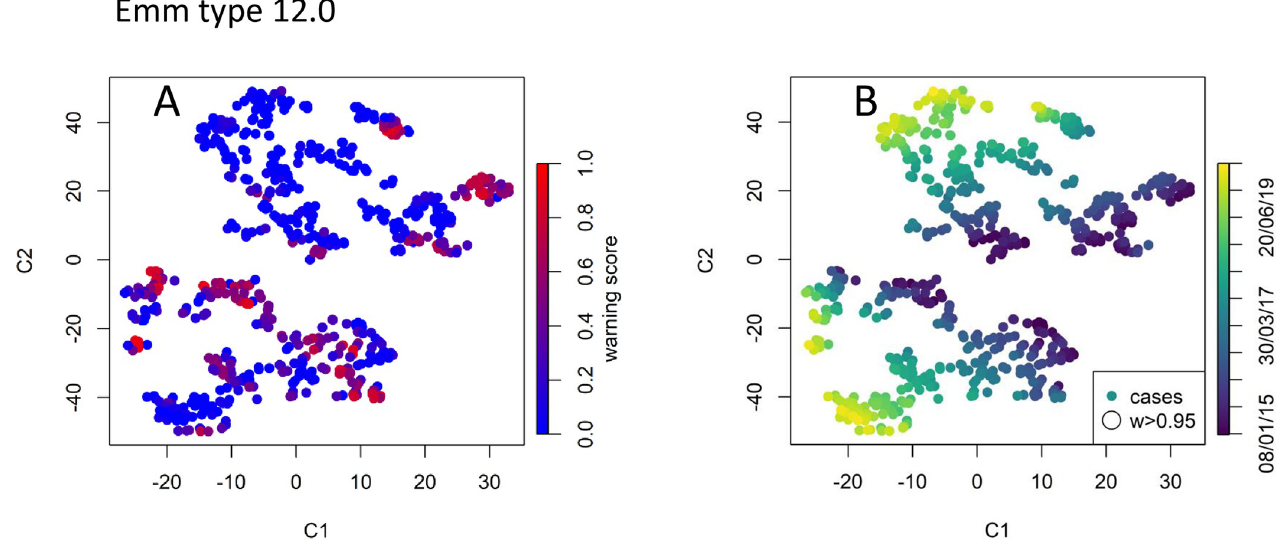
Fig 11. Data point embedding for the common emm type 12.0. No detected case is assigned a warning score higher than 0.95.